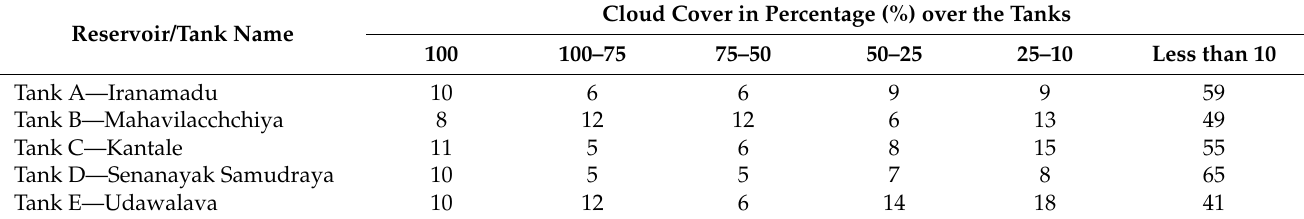
Table 2. Image percentage with different cloud cover